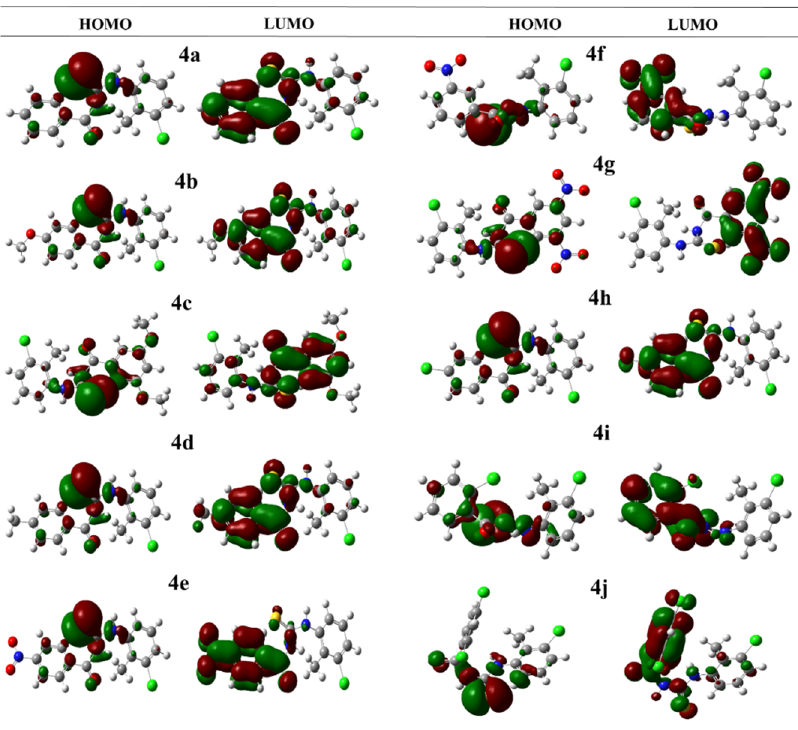
Figure 12. Showing HOMO LUMO structures of 1-aroyl-3-[3-chloro-2-ethylphenyl]thiourea hybrids [ 4a – j ]. Red, yellow and blue atoms indicate C, S and O atoms. Deep-red and deep-green parts indicate the different phases of molecular wave functions. Table 3. Energy parameters of 1-aroyl-3-[3-chloro-2-methylphenyl]thiourea hybrids [ 4a – j ].